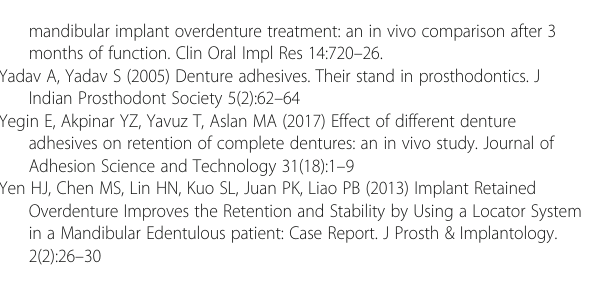
mandibular implant overdenture treatment: an in vivo comparison after 3 months of function. Clin Oral Impl Res 14:720 – 26. Yadav A, Yadav S (2005) Denture adhesives. Their stand in prosthodontics. J Indian Prosthodont Society 5(2):62 –